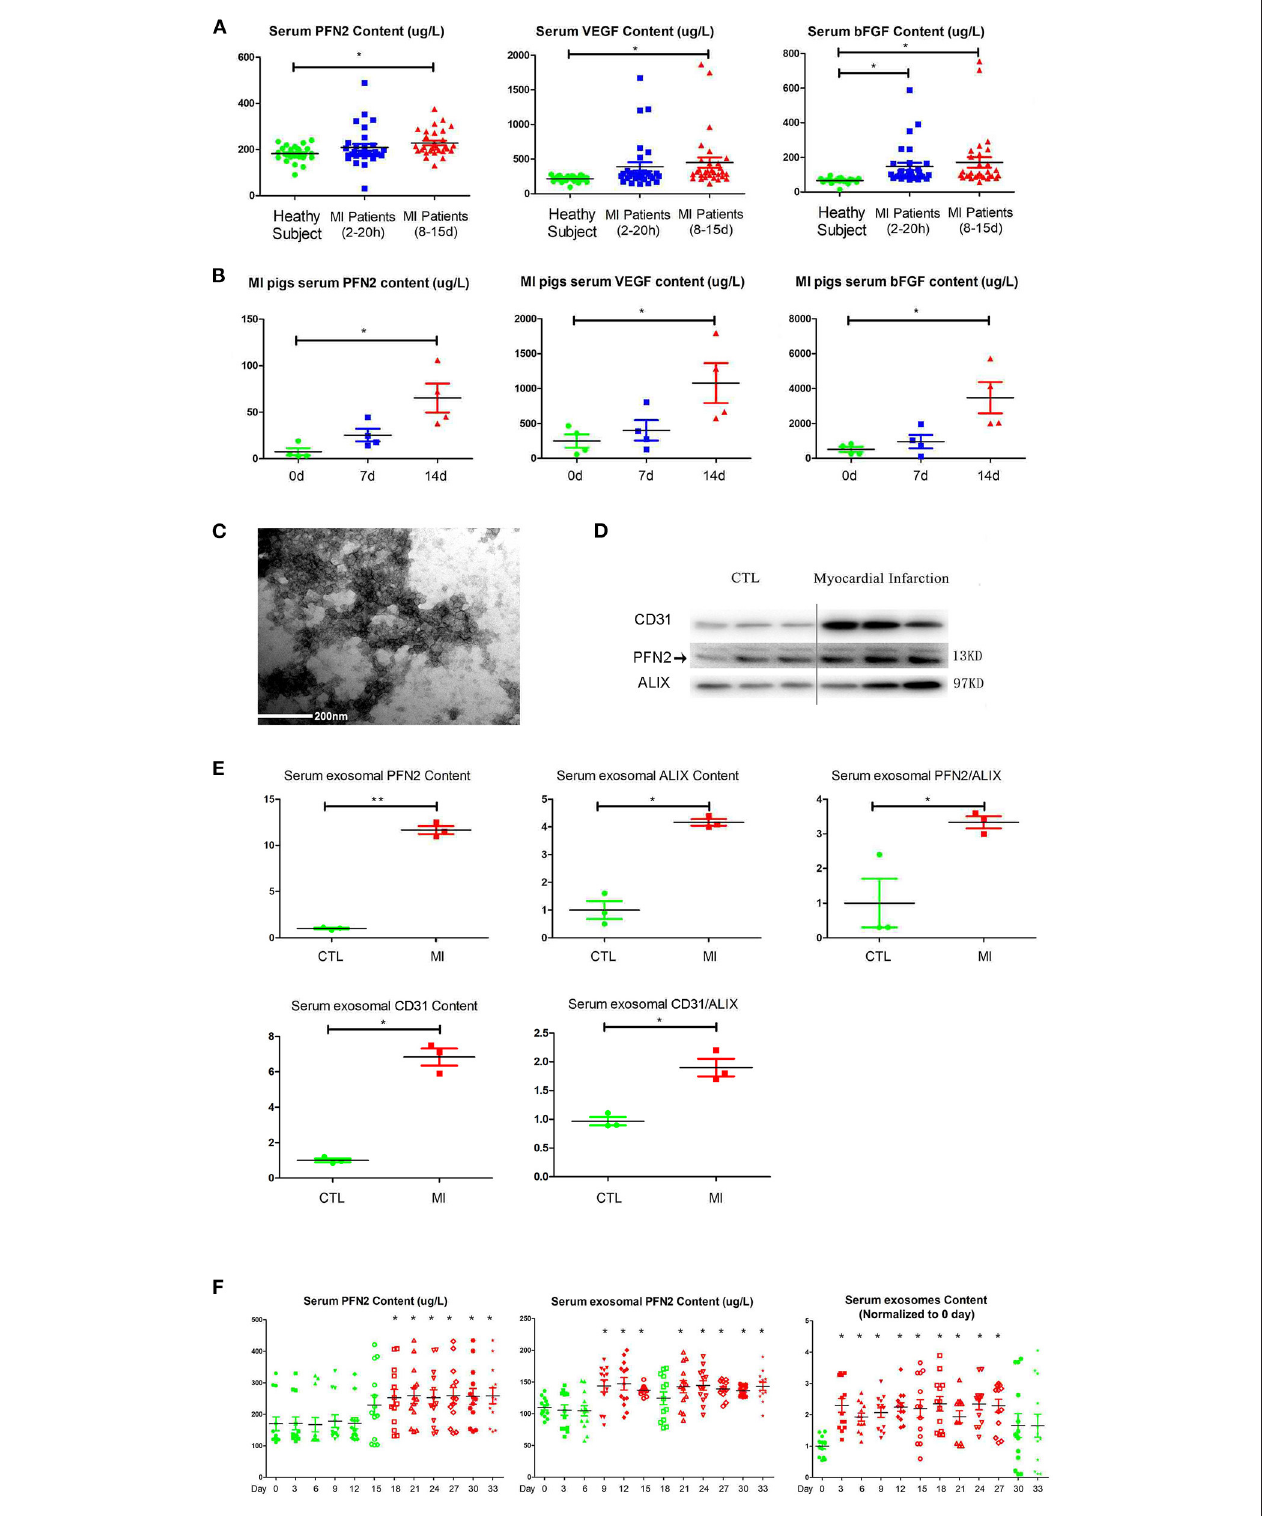
FIGURE 1 | Increased PFN2 and exosomal PFN2 levels in the serum of patients with MI and in animal models. (A) Enhanced PFN2 levels, VEGFA and bFGF levels in patients with MI (patients with MI 2–20h, n = 30; MI 8–15 d, n = 30; CTL, n = 24). (B) Enhanced PFN2 levels, VEGFA and bFGF levels in pigs with MI (pigs with MI, n = 4; CTL, n = 4). (C) Identification of serum exosomes in patients with MI by electron microscopy. (D) Exosomal PFN2 between CTL ( n = 3) and MI groups ( n = 3). (E) Exosomal PFN2 levels between CTL ( n = 3) and MI groups ( n = 3) (The protein level was normalized to control). (F) Serum PFN2 levels, Exosomal PFN2 levels and Exosomes in rats ( n = 13) before and after MI. * p < 0.05, one-way ANOVA and repeated-measures ANOVA (Tukey).